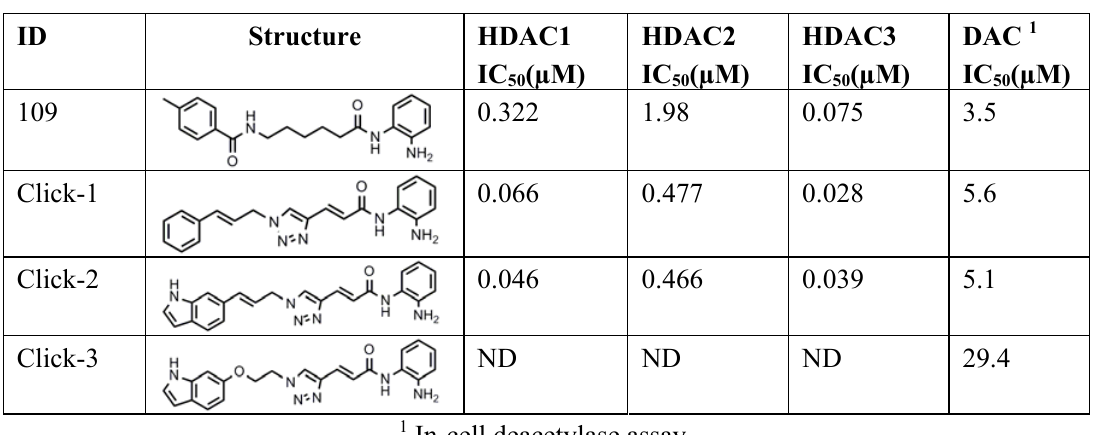
Table 1. HDAC inhibition data for 109 and click compounds.